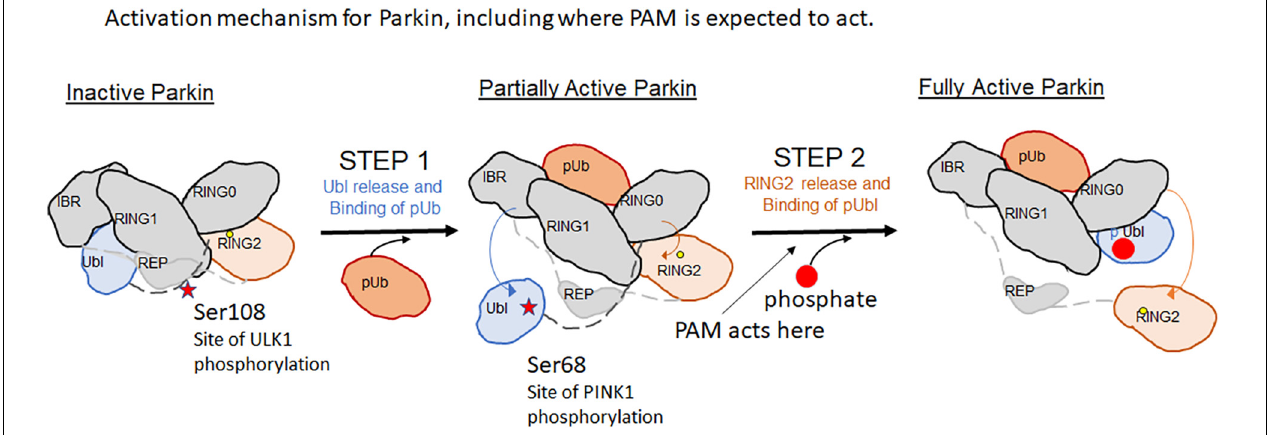
FIGURE 1 | Activation mechanism for Parkin, including where PAM is expected to act.